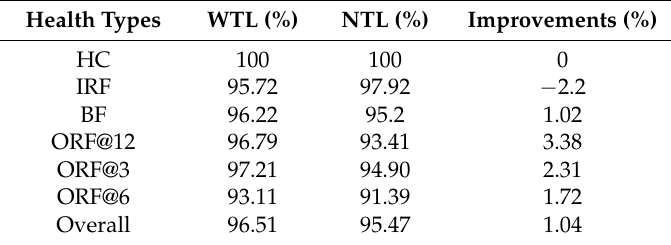
Table 6. Comparison analysis of the classification accuracies of transfer learning-based model (WTL) vs. without transfer learning (NTL).